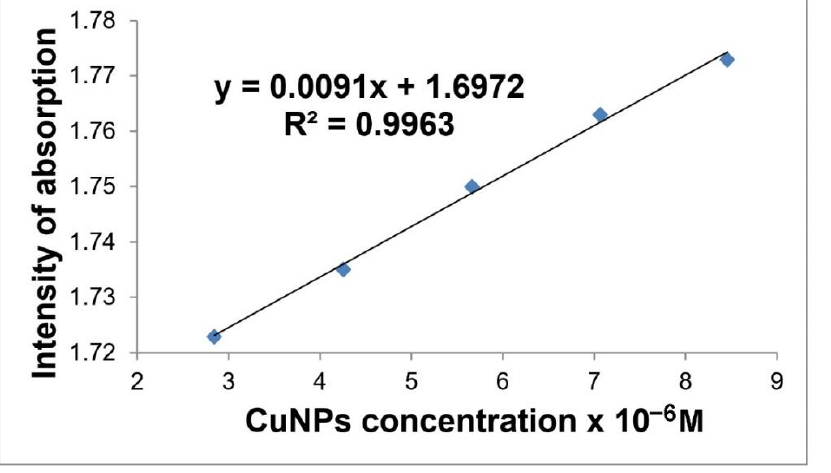
Figure 4. Linear dependence between the increasing of intensity of absorption on the Soret band and the concentration of CuNPs in the range 2.841 × 10 − 6 – 8.456 × 10 − 6 M. In the case of the CuNPs-TAmPP complex, the morphology of the surface is uneven, height distribution is 3 – 12 nm, and the rugosity Sa = 27 nm is 40 times higher than that of CuNPs, while the highest peak is again approximately even with the valley peak, but 20 times higher in comparison with that of CuNPs, Sp = 71 nm, and Sv = − 64 nm. The uniform distribution of round CuNPs on the AFM surface images might indicate a coordination of CuNPs by nitrogen atoms in the core of porphyrin or by amino groups from the periphery of the porphyrin ring.